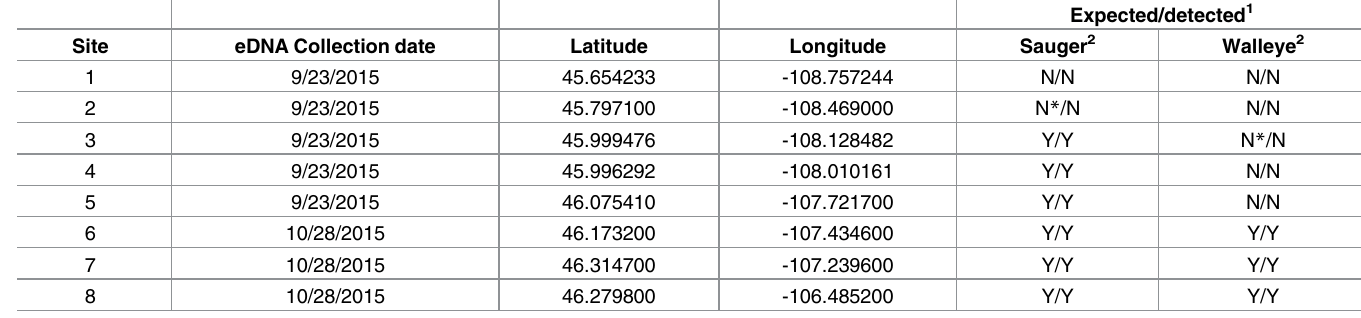
Table 4. Collection information for in vivo testing of the sauger and walleye eDNA assays. Sampleswere collectedin the Yellowstone River, Montana. Detection expectation was determinedfrom 2016 survey